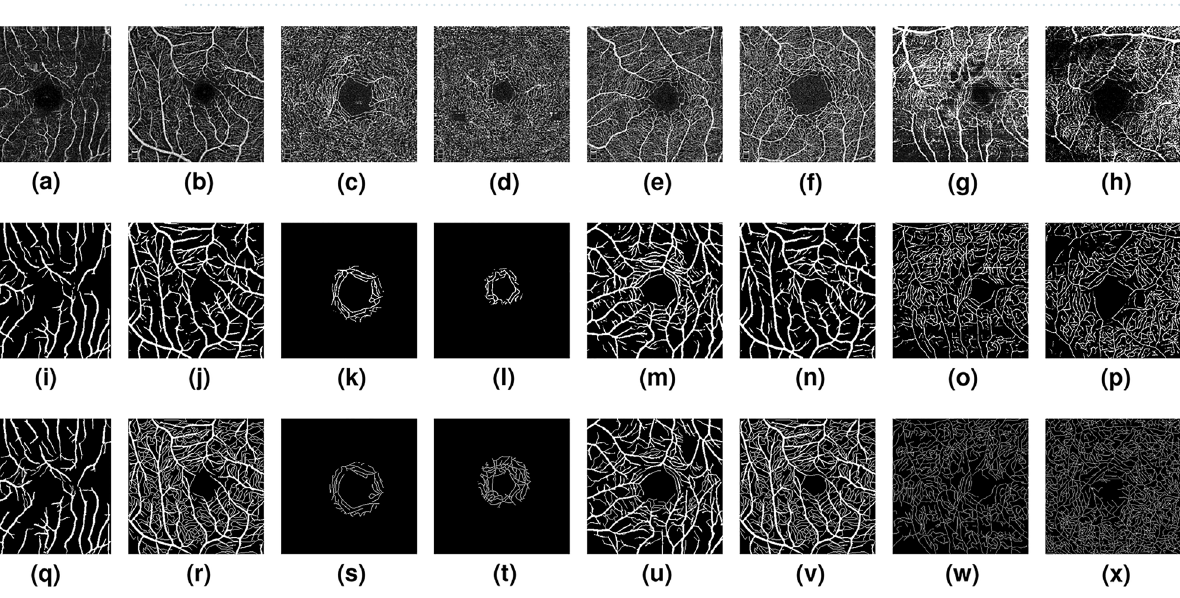
Figure 5. Generalization ability of a W-Net trained for A/V segmentation. Results of our model trained on DRIVE and tested on ( a ) DRIVE, ( b ) LES-AV.